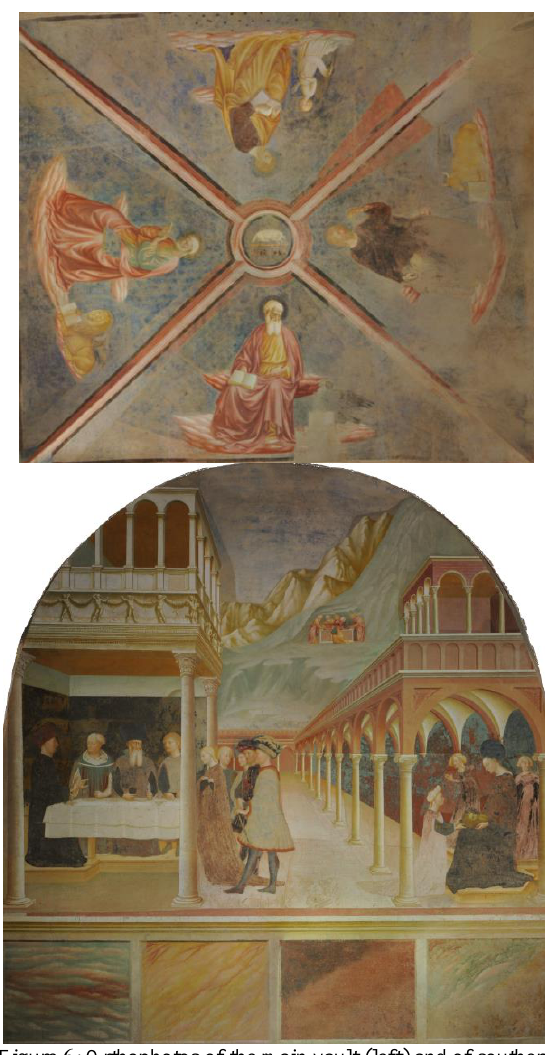
Figure 6 : Orthophotos of the main vault (left) and of southern wall (right)